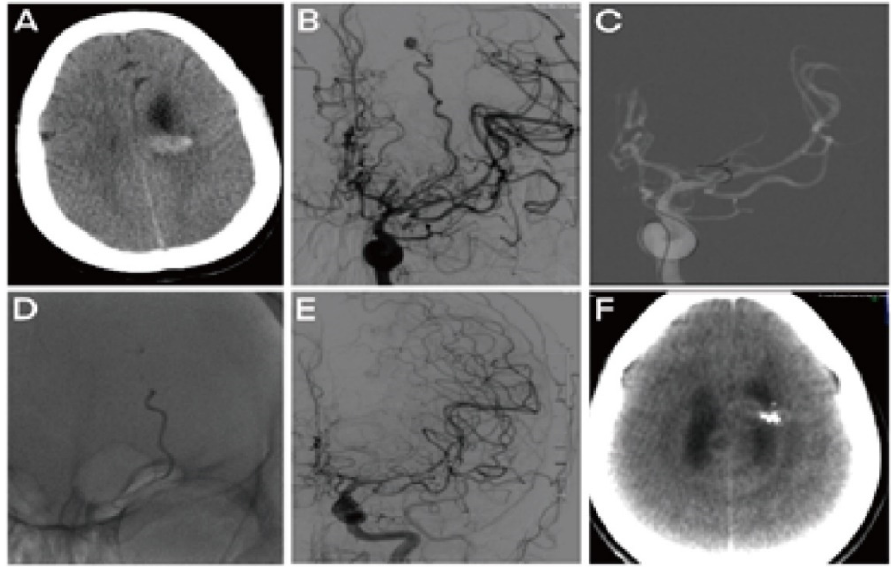
Figure 2. AVM with peripheral hemorrhagic aneurysm. ( A ) Preoperative CT revealed hemorrhage